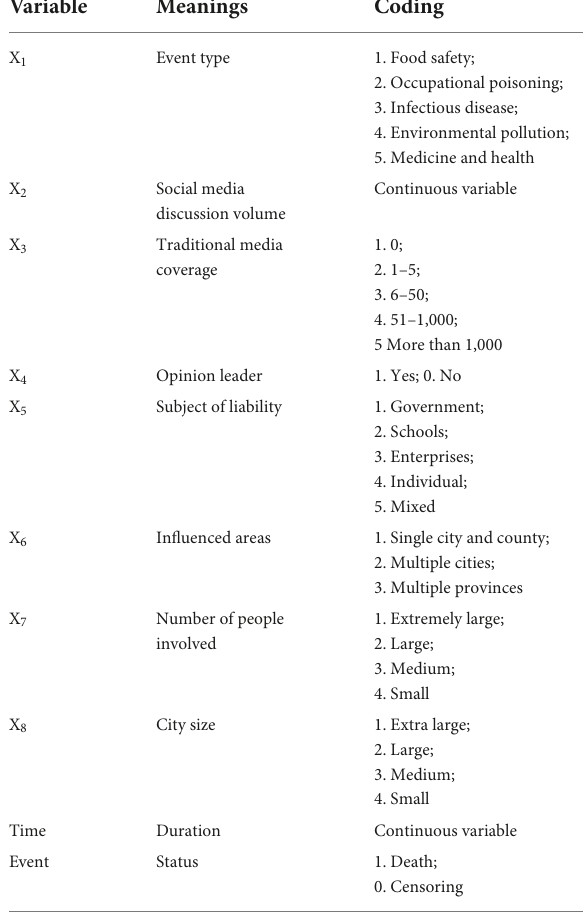
TABLE 1 Variable coding.